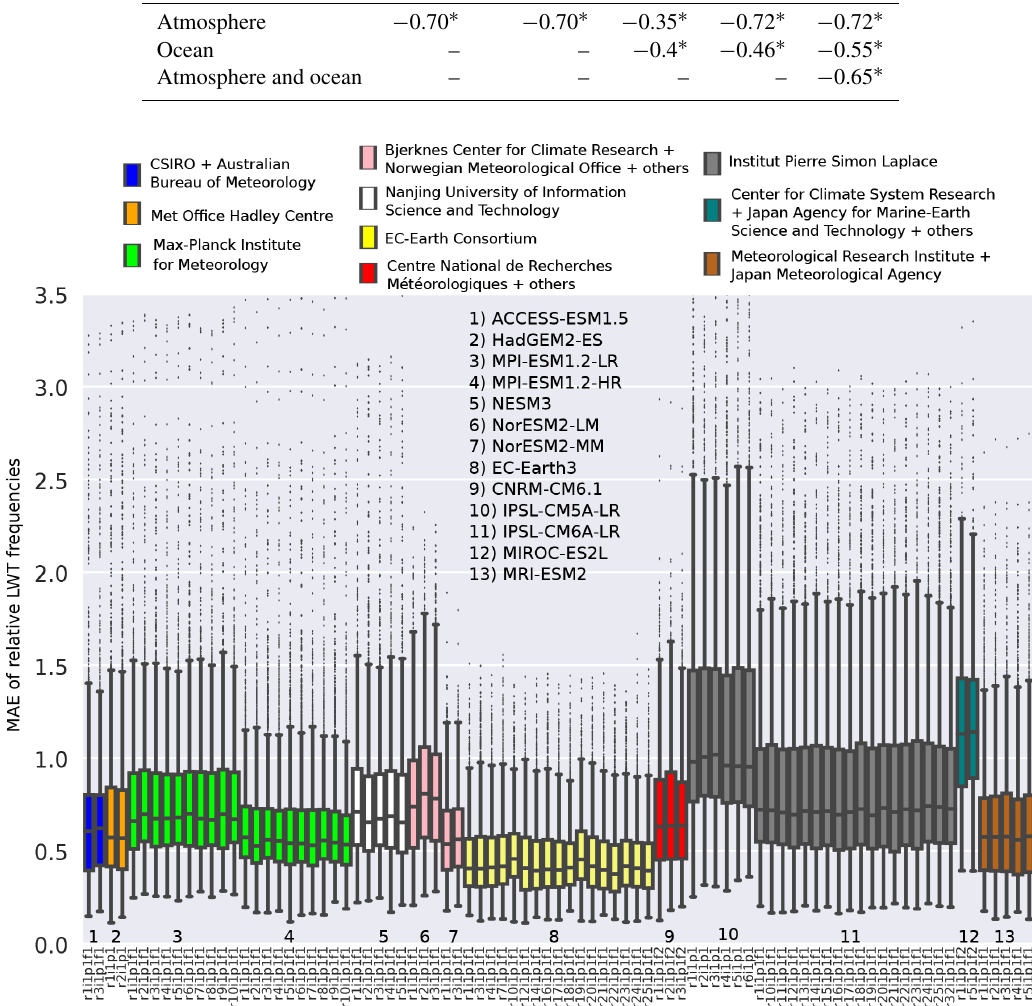
Figure 12. As Fig. 11 but considering 72 additional runs for a subset of 13 distinct coupled models. All available runs per model are taken into account, except for IPSL-CM6A-LR for which the analyses were stopped after considering 17 additional ensemble members. The colours referring to the coordinating research institute are identical to those in Fig. 11, except for the Nanjing University of Information Science and Technology, which is painted white. Up to two ensembles per institute are shown, and the abbreviations of the individual coupled models are indicated by numbers. The exact run specifications are provided along the x